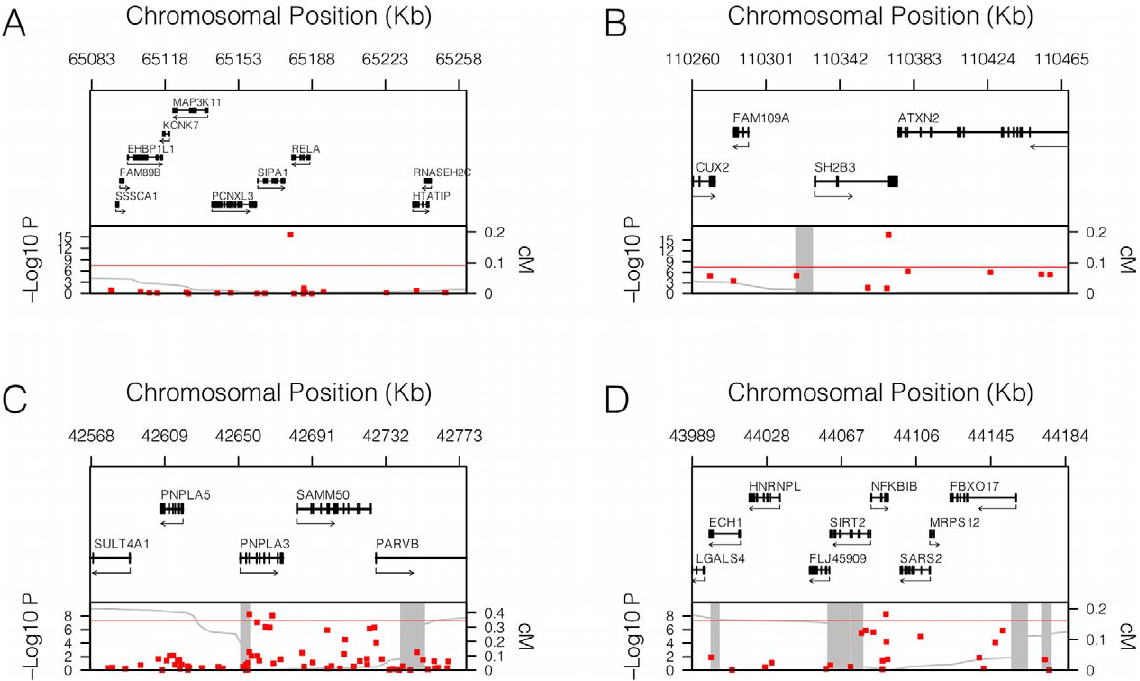
Figure 2. Genomic context of novel associations. Genomic context for each of the four novel loci with significant association with sICAM-1 concentration. (A) RELA locus (11q13.1); (B) SH2B3 locus (12q24.12); (C) PNPLA3 locus (22q13.31); and (D) NFKBIB locus (19q13.2). Upper panel: Genes from RefSeq release 25. Only one isoform is shown when multiple splicing variants are known. Lower Panel: SNPs are shown according to their physical location and –log 10 P-values for association with sICAM-1 (red dots). The red line represents the genome-wide significance threshold of 5 6 10 2 8 . Also shown is the genetic distance in cM from the lowest P-value SNP (light grey line) along with the position of recombination hotspots (light grey vertical bars). Recombination rates and hotspots are based on HapMap data, as described by McVean et al. [43] and Winckler et al. [44]. doi:10.1371/journal.pgen.1001374.g002 trends, no additional locus reached genome-wide significance Model selected SNPs were tested for association with other when a genotypic test, which does not assume an additive model of available inflammation markers (C-reactive protein and fibrino- association, was conducted. gen). No significant association was noted (P . 0.01) after adjusting